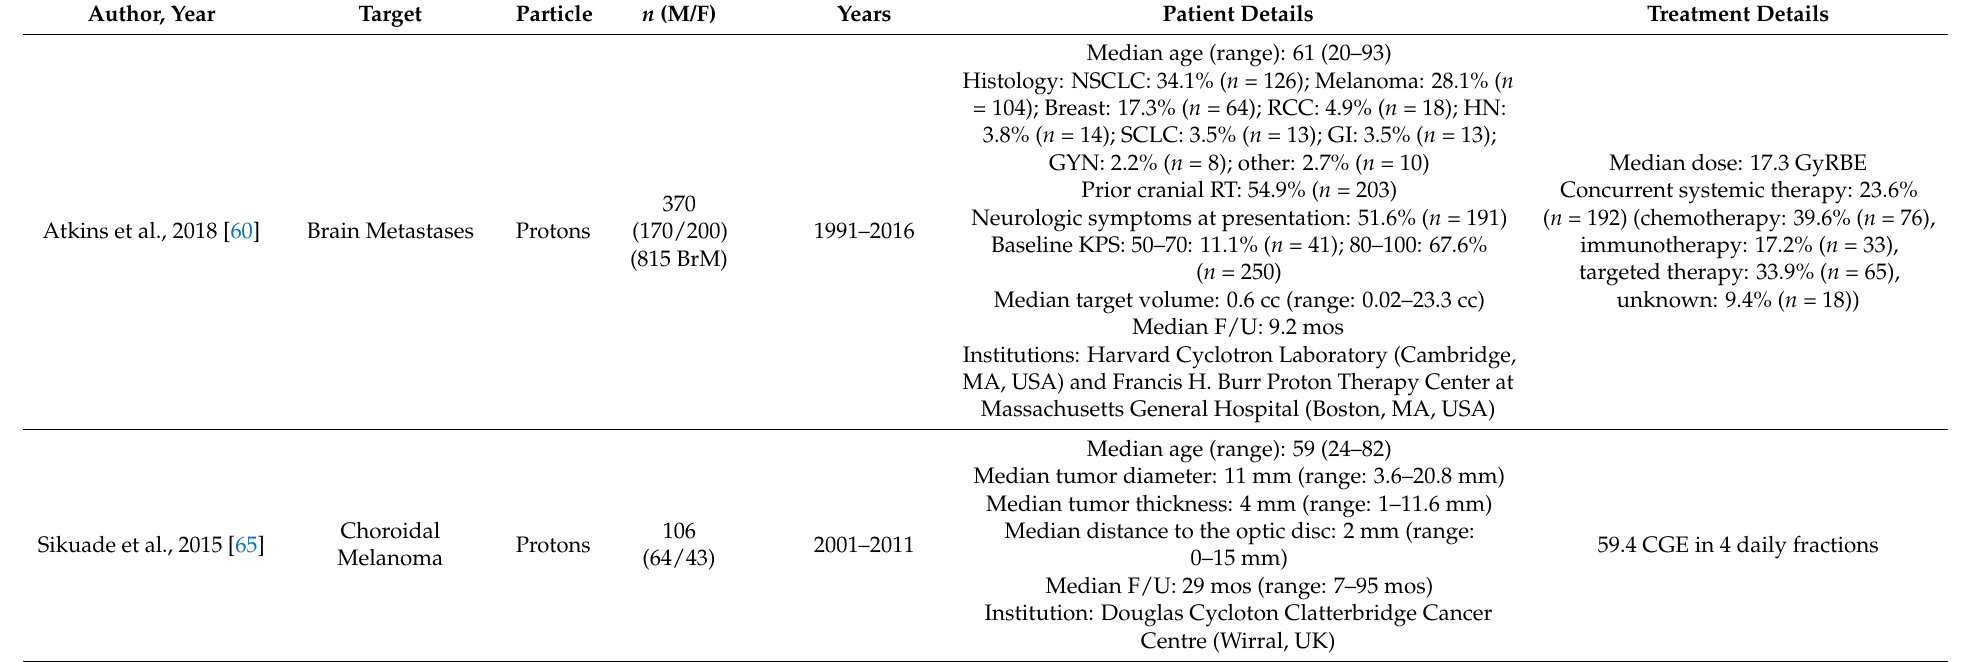
Table 1. Patient and treatment details in select studies utilizing particle